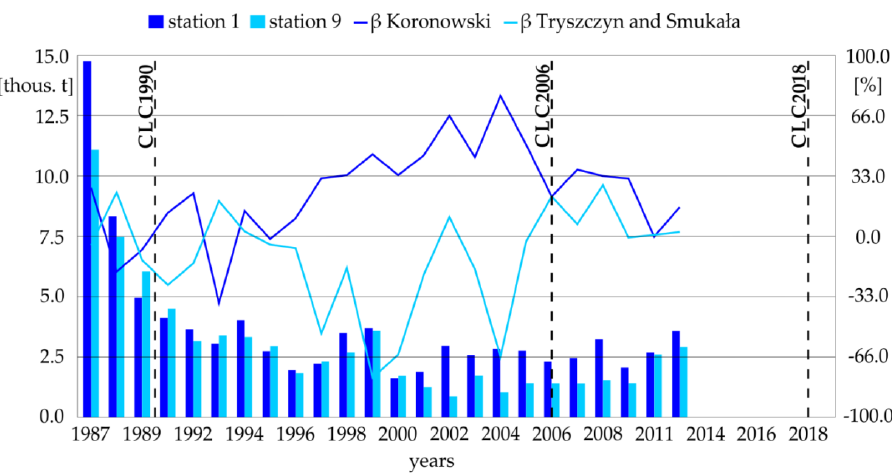
Figure 3. The course of changes in the inflow and outflow of the SSL for the cascade of Brda River reservoirs against the course of changes in the suspended sediments trapping efficiency (β) in the main reservoir of the cascade—Koronowski Reservoir and the below lying reservoirs—Tryszczyn and Smukała for the period 1987–2013. Smukała for the period